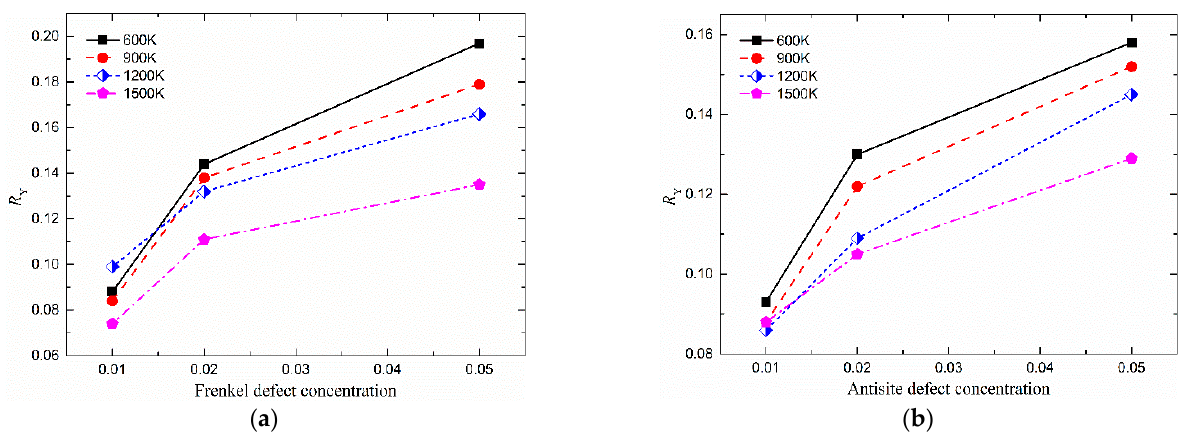
Figure 10. R Y as a function of the concentration of Frenkel defects ( a ) and antisites ( b ) for different temperatures.